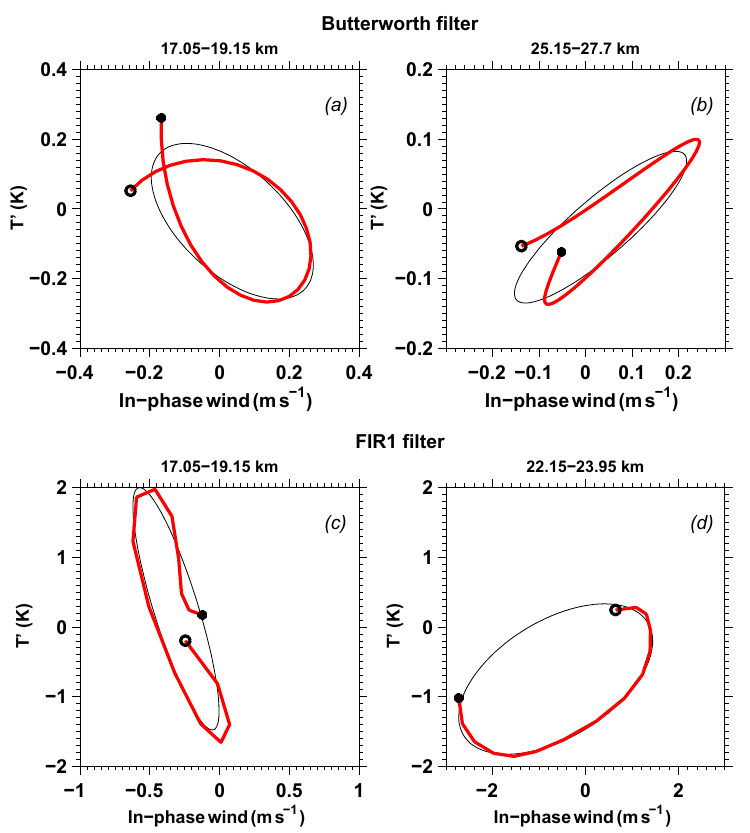
Figure 7. Hodographs of in-phase wind (ms − 1 ) versus temperature fluctuations (K) obtained using Butterworth (a, b) and FIR1 (c, d) filters. An open circle and a solid circle in each hodograph indicate the lowest and highest altitudes, respectively. The thin curves represent the elliptical